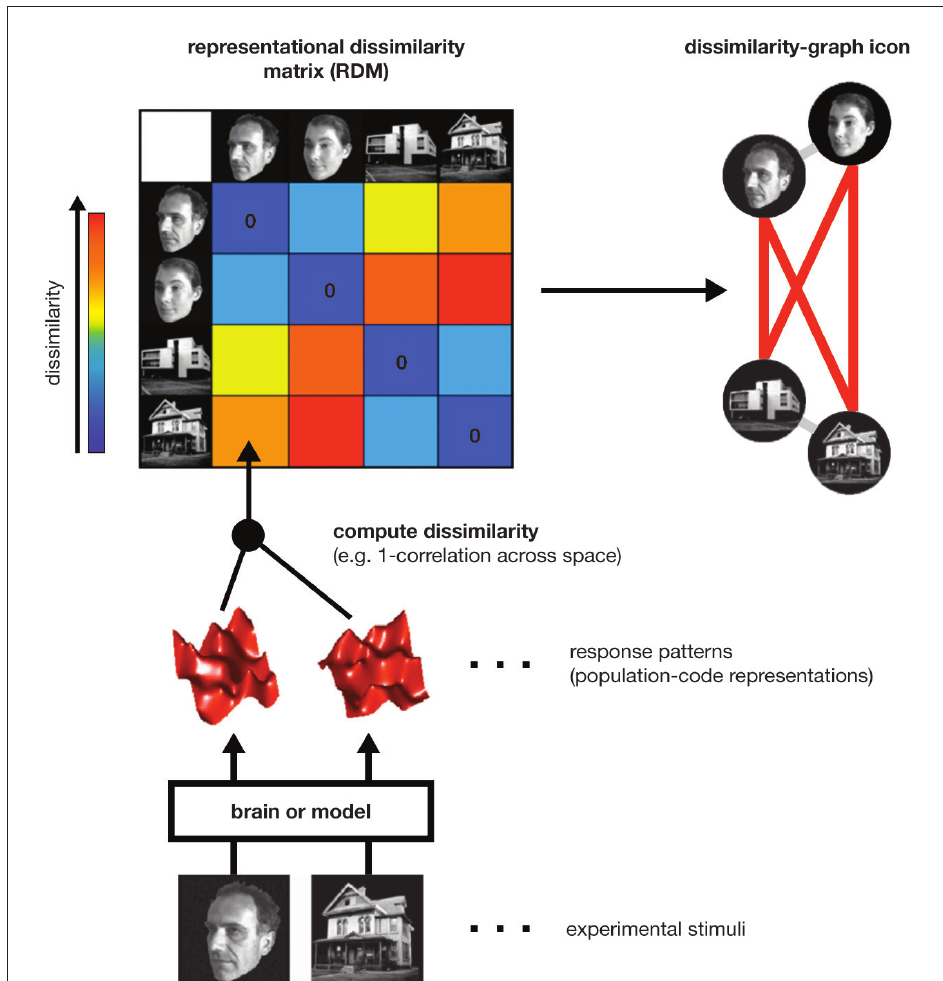
Figure 1 | Computation of a representational dissimilarity matrix. For each pair of experimental stimuli, the response patterns elicited in a brain region or model representation are compared to determine the stimuli’s representational dissimilarity. The dissimilarity between two patterns can be measured as 1 minus the correlation (0 for perfect correlation, 1 for no correlation, 2 for perfect anticorrelation). These dissimilarities for all pairs of stimuli are assembled in the representational dissimilarity matrix (RDM). Each cell of the matrix then compares the response patterns elicited by two images and the matrix is symmetric about a diagonal of zeroes. To visualize the representation, we can arrange the stimuli according to response-pattern dissimilarity, such that stimuli are placed close together if they elicited similar response patterns and far apart if they elicited dissimilar response patterns. The color of each connection line here indicates whether the response-pattern difference was significant (red: p < 0.01; light gray: p ≥